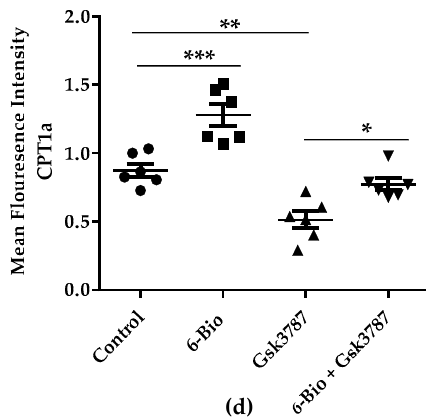
Figure 5. Wnt stimulate fatty acid oxidation (FAO) metabolism through PPAR δ - Cpt1-axis to regulate BL development and Hatching. (a – b) qRT-PCR analysis for FAO regulating genes Cpt1 and Pdk4 expression by 6-Bio (400 nM), Gsk3787 (15 µM) and 6-Bio + Gsk3787 treated groups. n = 5 BLs. (c) Immunofluorescence imaging showing Cpt1 expression. DAPI labeled nuclei in blue. (d) Bar graph data of mean fluorescence intensities presented as a means ± SEM from three individual sets of experiment, including n = 20 BLs per group in each replicate. * p < 0.05; ** p < 0.01; *** p < 0.001 indicates significant difference. Original magnification 100×.